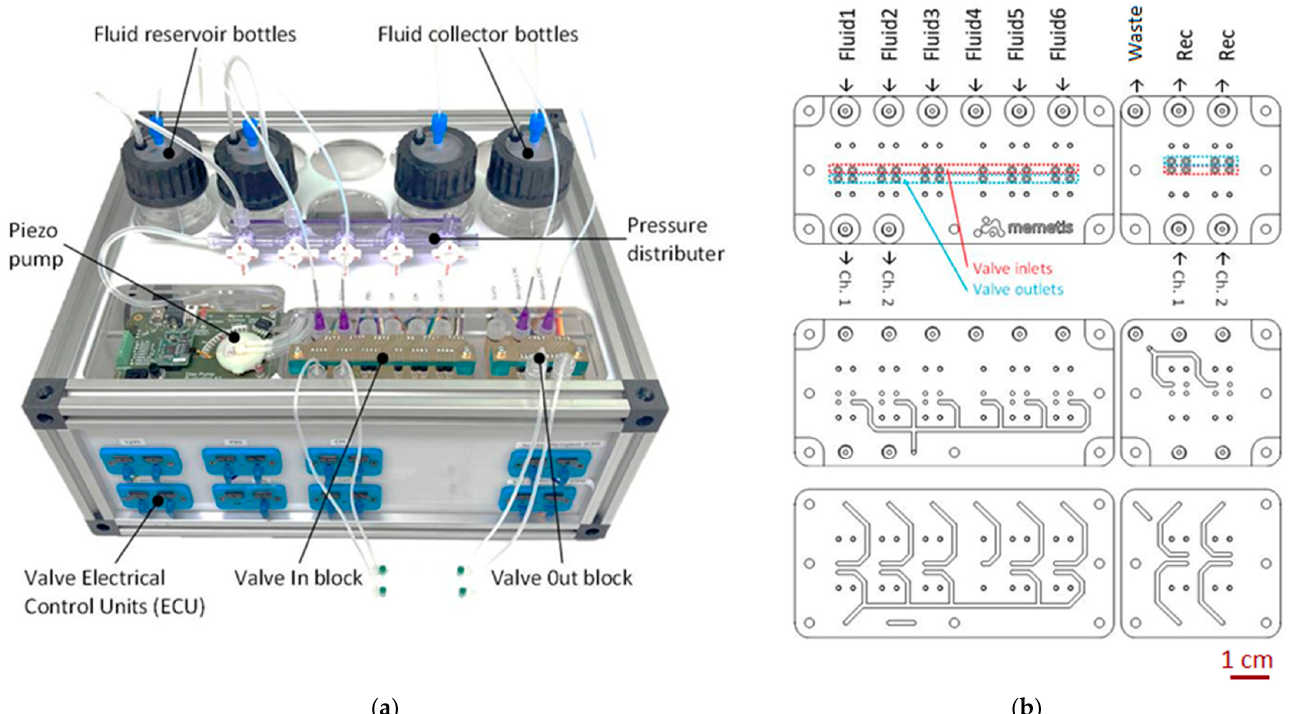
Figure 2. ( a ) Fluidic control unit for cell culture integrated in a housing; ( b ) schematic top view of fluid distribution circuit (top); cut view of first channel level (middle); cut view of second channel level (bottom). The system is designed to distribute different input fluids to the fluidic cell culture unit and from there to collector bottles. The fluids are transported by pressure-driven